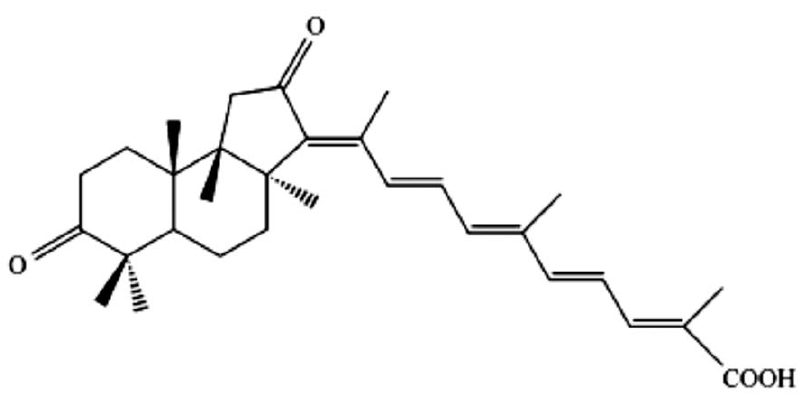
Figure 1. Molecular structure of Rhabdastrellic acid-A.